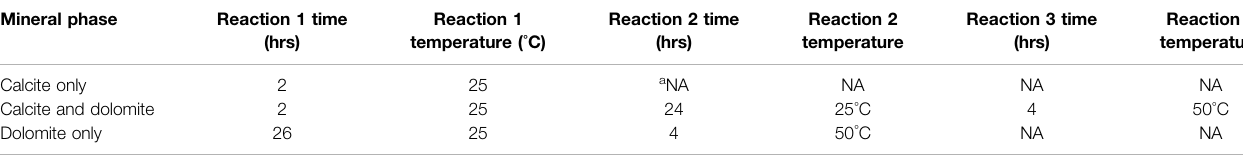
TABLE 1 | Parameters used for extraction of CO 2 from calcite and dolomite phases. Mineral phase